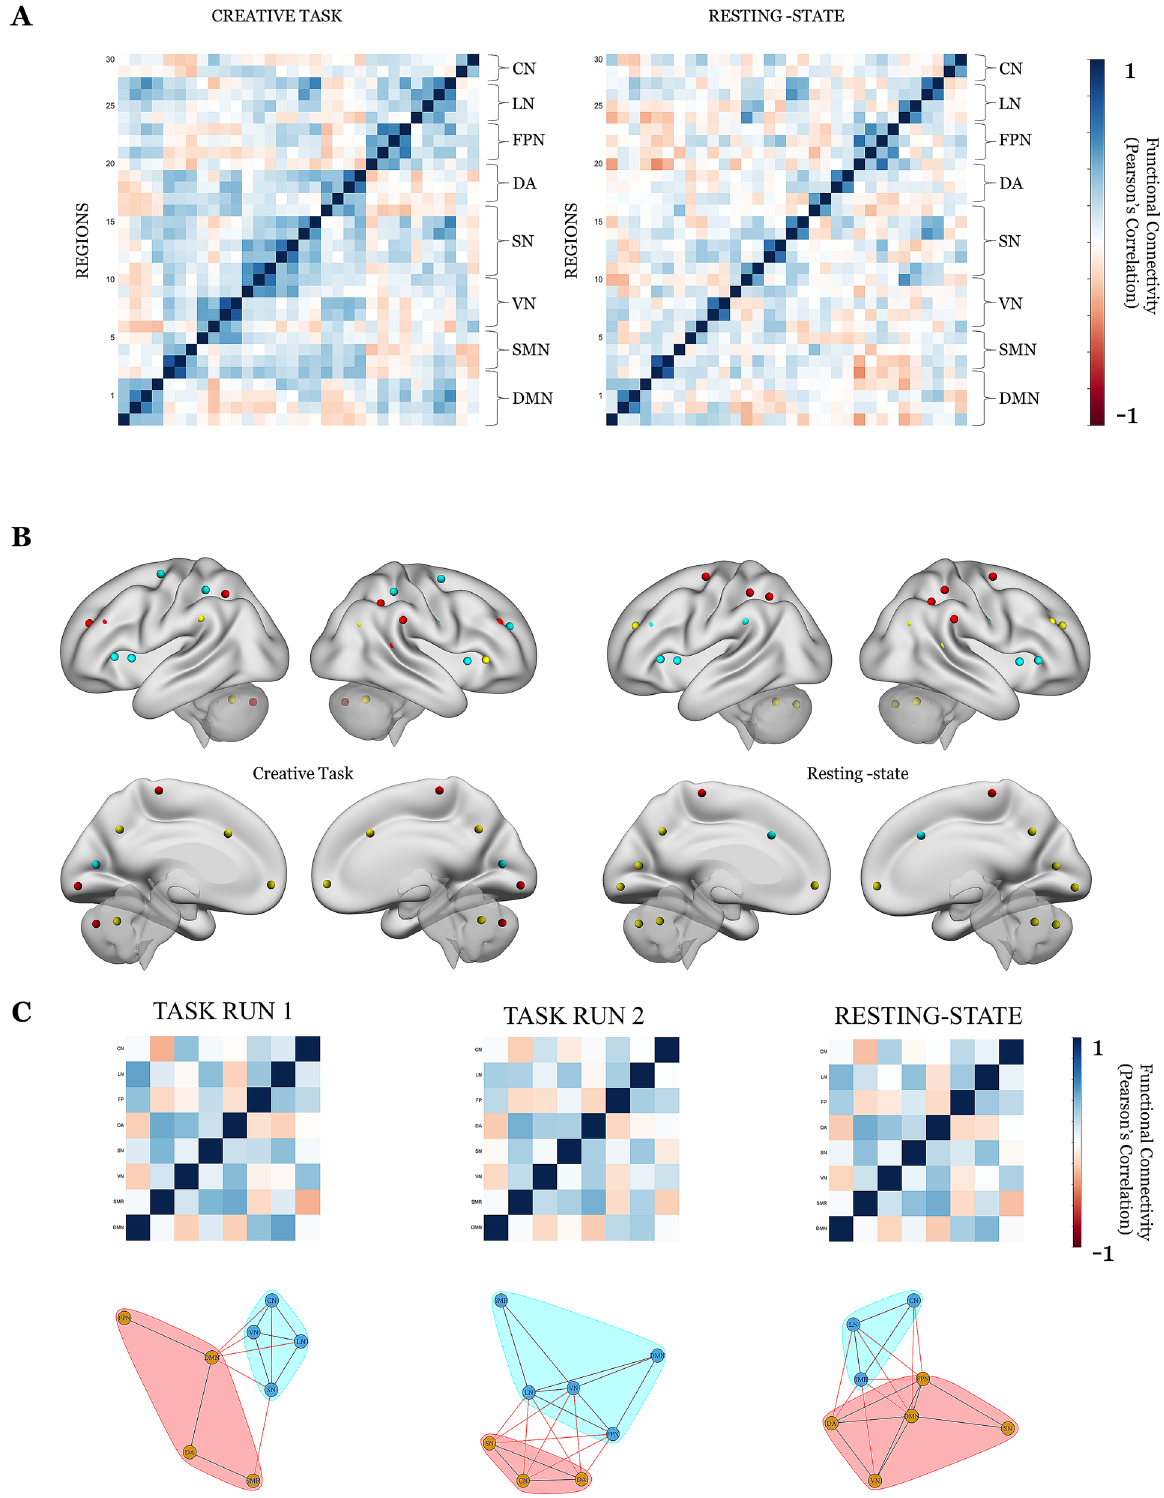
Figure 2. Comparison of the creative task session and resting-state session using correlation map indicating a similar intrinsic network organization. ( A ) Group average of the creative task and resting-state functional connectivity matrices using z-scored Pearson correlation. The brain networks have been represented on the sides. Intra-module functional connections can be seen within the functional systems. The functional connectivity matrix for the overall creative task (on the left), while the resting-state functional connectivity matrix for the overall resting-state session (on the right) represents correlations of intrinsic functional network architecture. ( B ) A standard community detection approach called fast-greedy algorithm (Clauset et al.) was used to partition the overall creative task session and resting-state session into functional brain networks. Each node colour specifies a community. ( C ) Division of the longer creative task session into two halves, i.e. task session 1 and task session 2 and comparison of results with the resting-state session. Network-specific static configuration results for the task session 1, task session 2 and resting-state session represented by functional connectivity matrices and the community detected